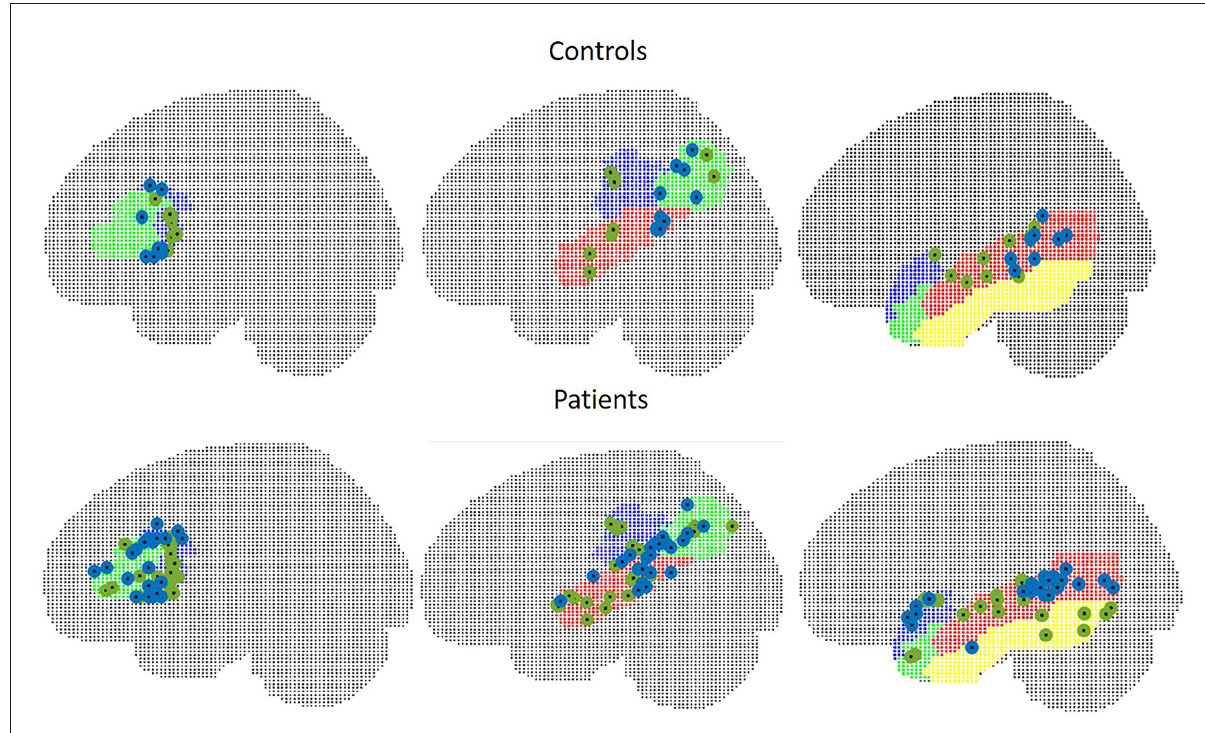
FIGURE7 Peak intensity values of MEG (green) and fMRI (blue) in control subjects (upper figure) and in patients (lower figure). Left: frontal ROI, middle: temporo-parietal ROI, right: other temporal areas.